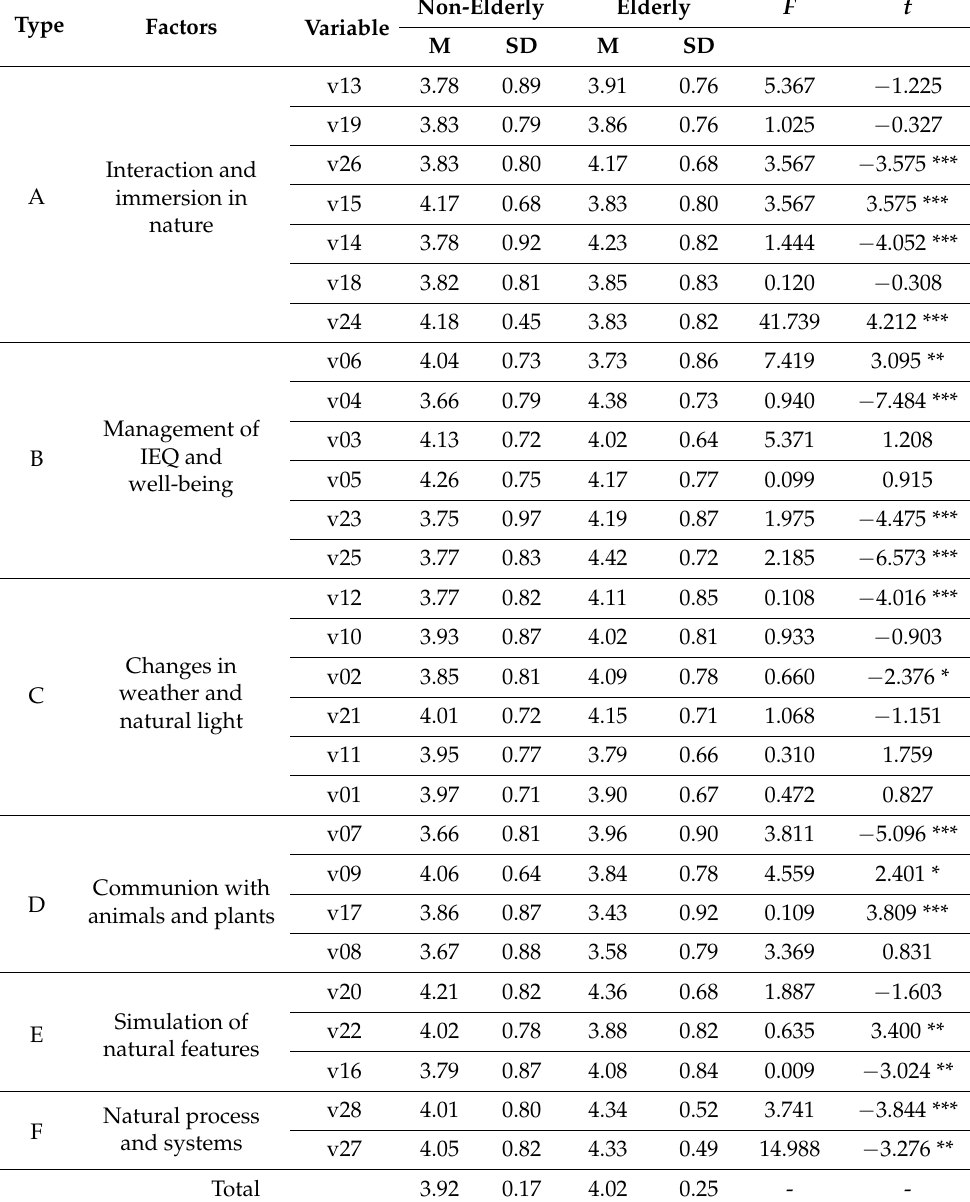
Table 6. T-test on the preference mean of the elderly and non-elderly. Type Factors Variable